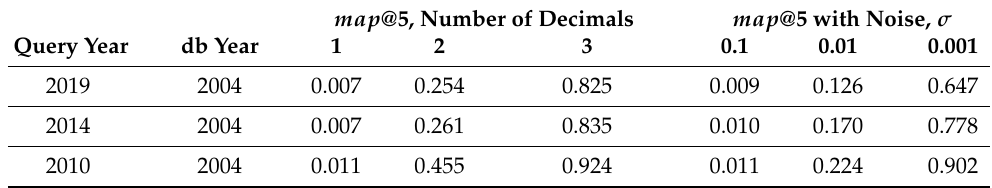
Table 4. No learning retrieval baseline using Faiss similarity search and modified node